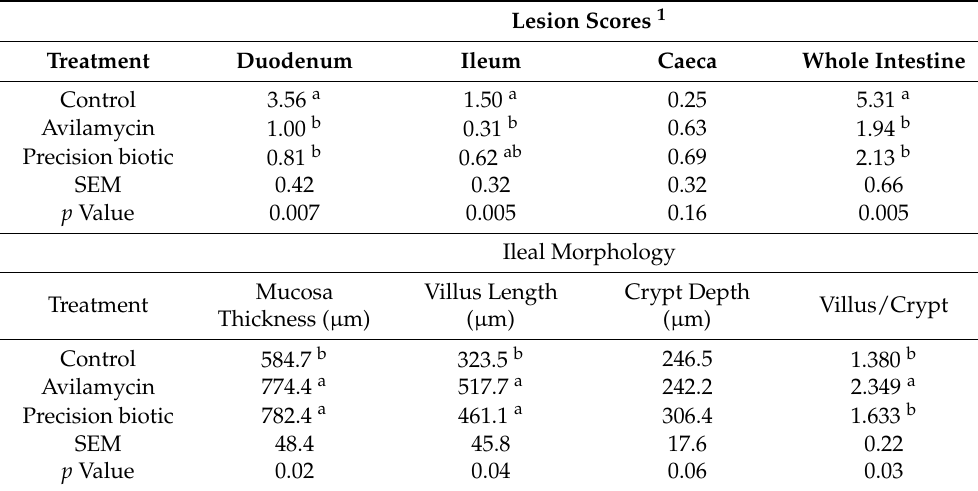
Table 7. Intestinal lesion score and ileal morphology of broiler chickens at 28 days of age according to the experimental treatments (Trial